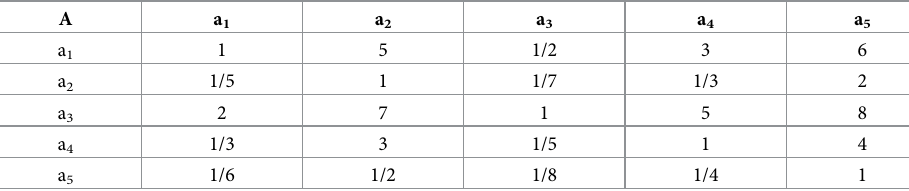
According to the same method and steps, the eigenvectors and the consistency ratio of matrix O and B were calculated. The results showed that they also passed the consistency test.